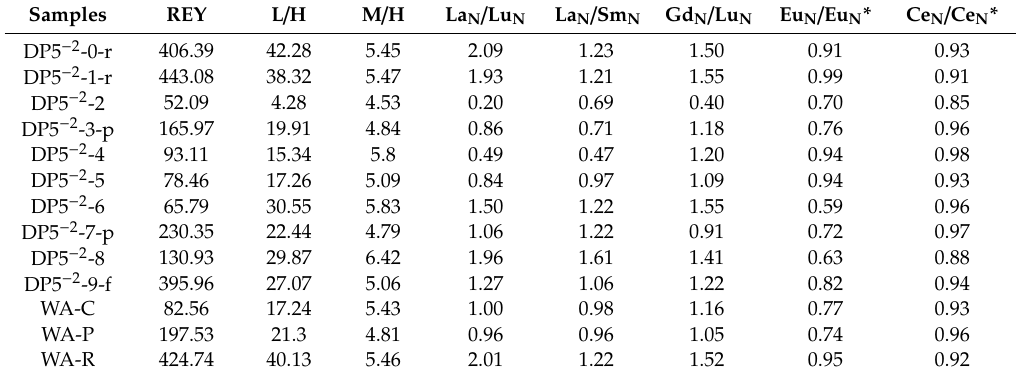
Table 7. REY geochemical parameters for the No.5 − 2 coal samples from Dongpo Mine (REY, µ g / g).